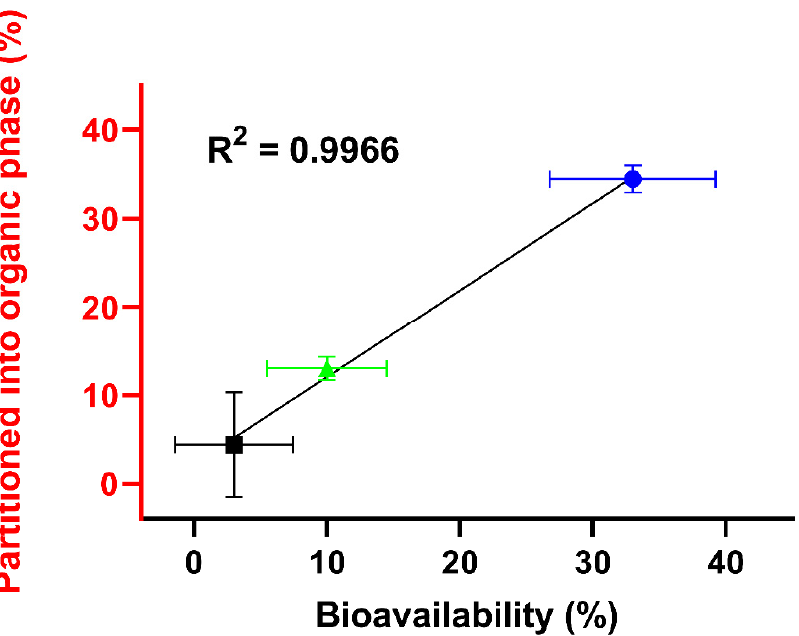
Figure 5. Correlation of in vitro fraction partitioned into the organic phase after 80 min, determined by biphasic dissolution and in vivo BA of neat CorA ( ■ ), CorA-povidone ( ● ) and CorA-copovidone ( ▲ ) administered as an aqueous suspension.